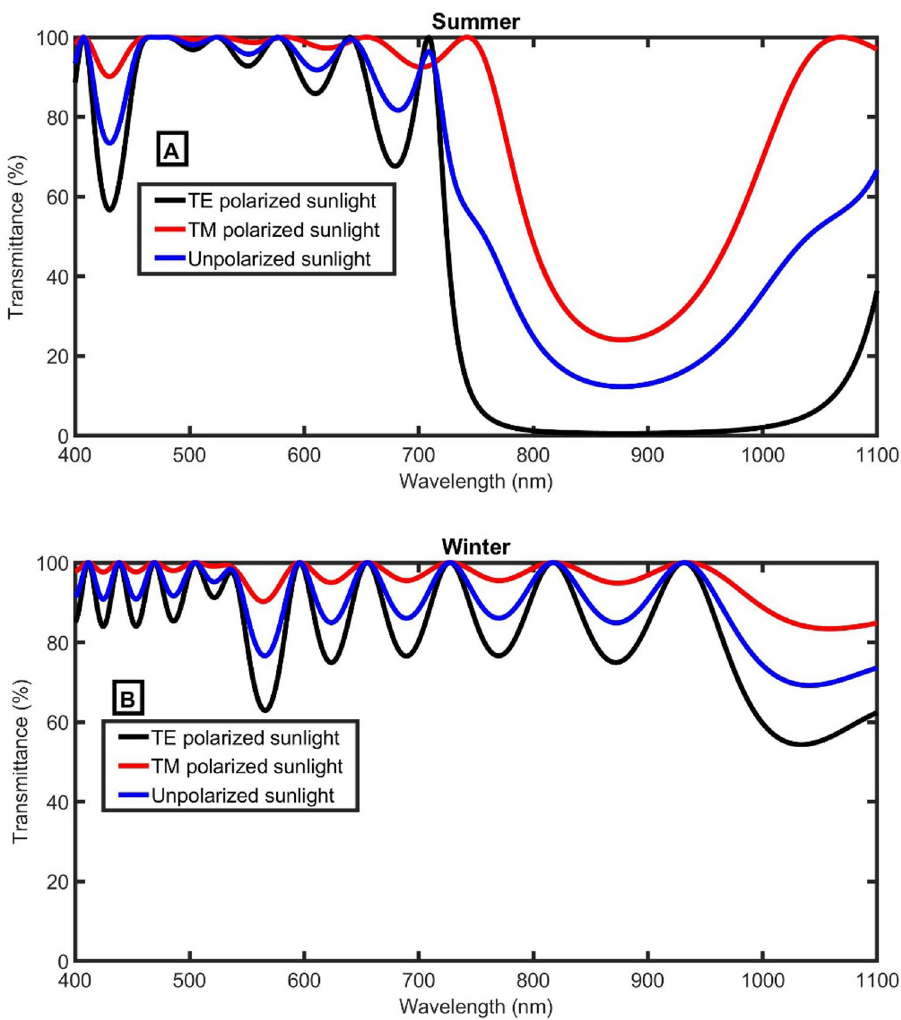
Figure 6. The transmittance of the proposed smart windows at 40 degrees, dB = 270 nm, and N = 6 ( A ) in Summer, and ( B ) in